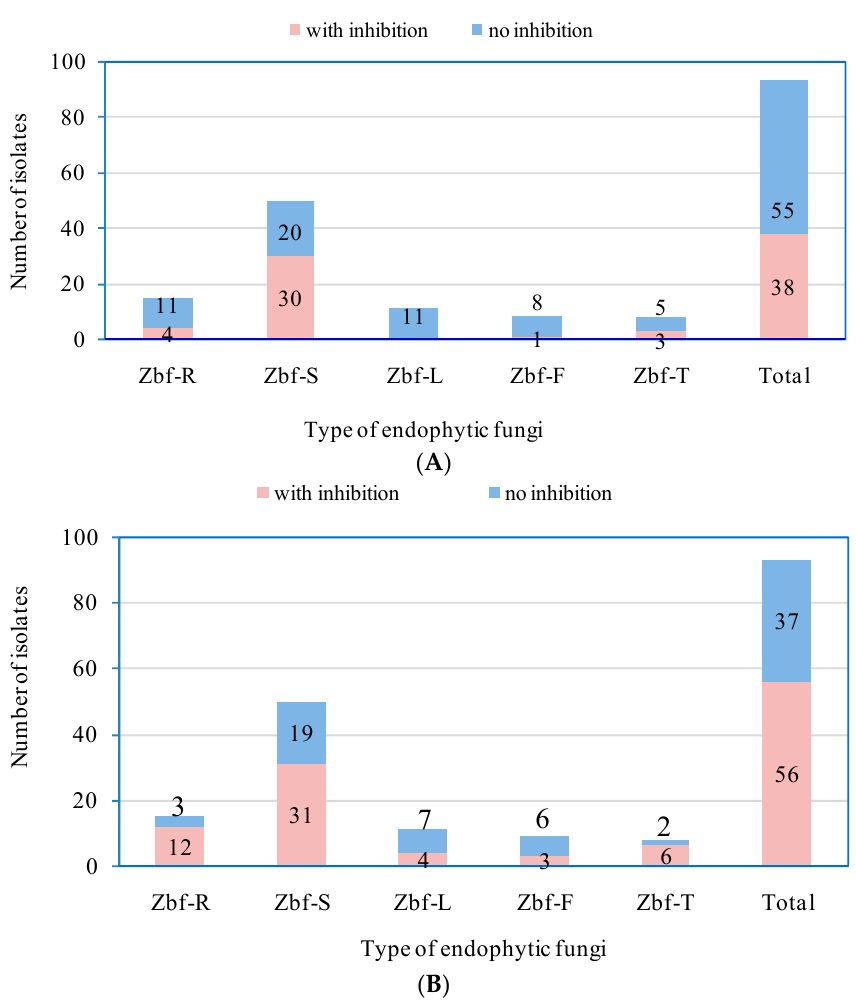
Figure 5. The summarized numbers of endophytic fungal isolates with inhibition and without inhibition against the pathogenic fungi F. sambucinum ( A ); and P. zanthoxyli ( B ) of Z. bungeanum . The values presented in the graph are the corresponding numbers of endophytic isolates with inhibition or without inhibition.